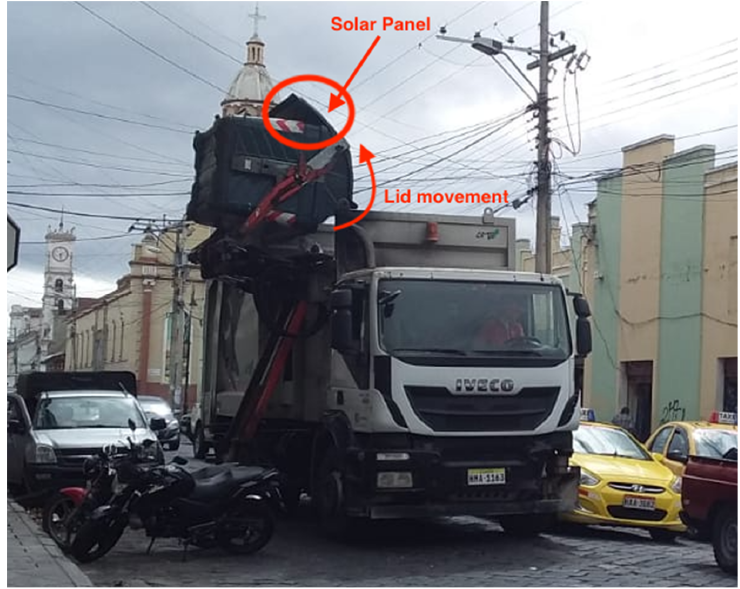
Figure 6. Waste collection process [23].